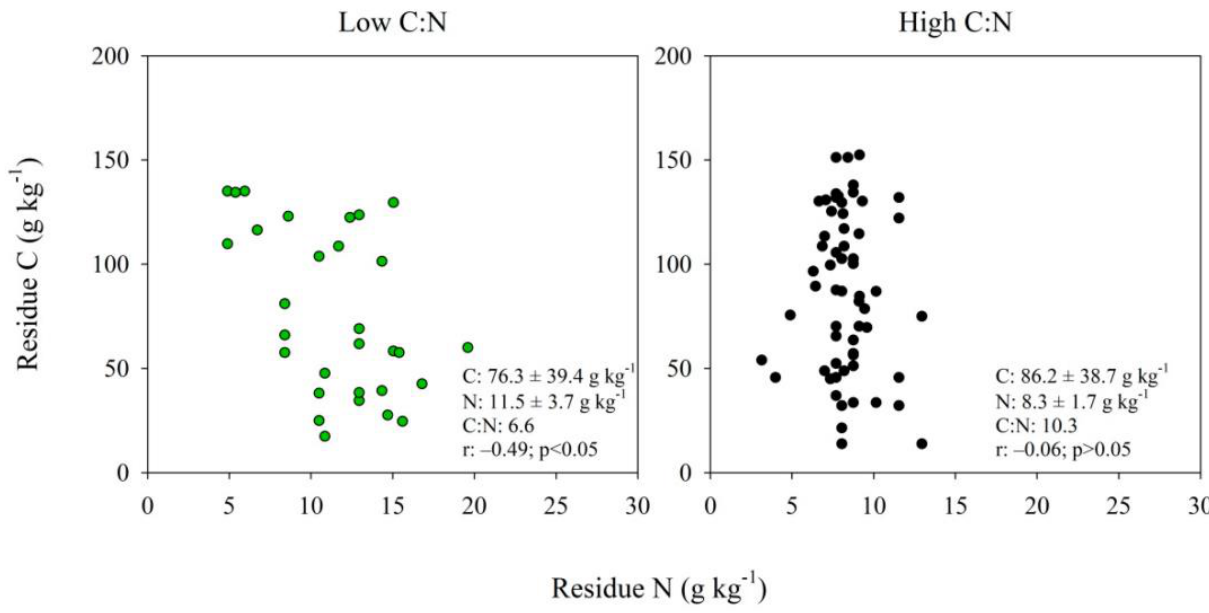
Figure 3. Correlation of carbon and nitrogen in the residue (g kg − 1 ) with additions of high and low C:N after 50 days of incubation. The mean of C and N in the residues was correlated by Pearson correlation ( p < 0.05).